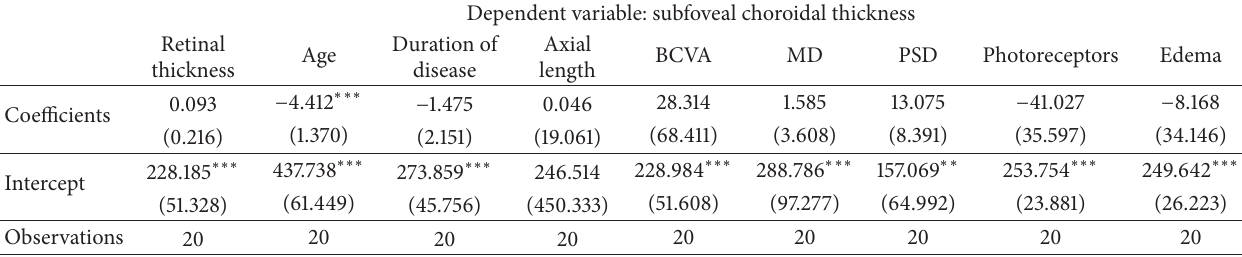
Table 4: Beta regression coefficients of subfoveal choroidal thickness on different predictors (univariate analysis). Each column corresponds to a different regression analysis showing the estimated regression coefficient and, in brackets, the corresponding standard error. Asterisks represent the significance according to the legend on the bottom. Among tested variables, age is the only significant predictor of the subfoveal choroidal